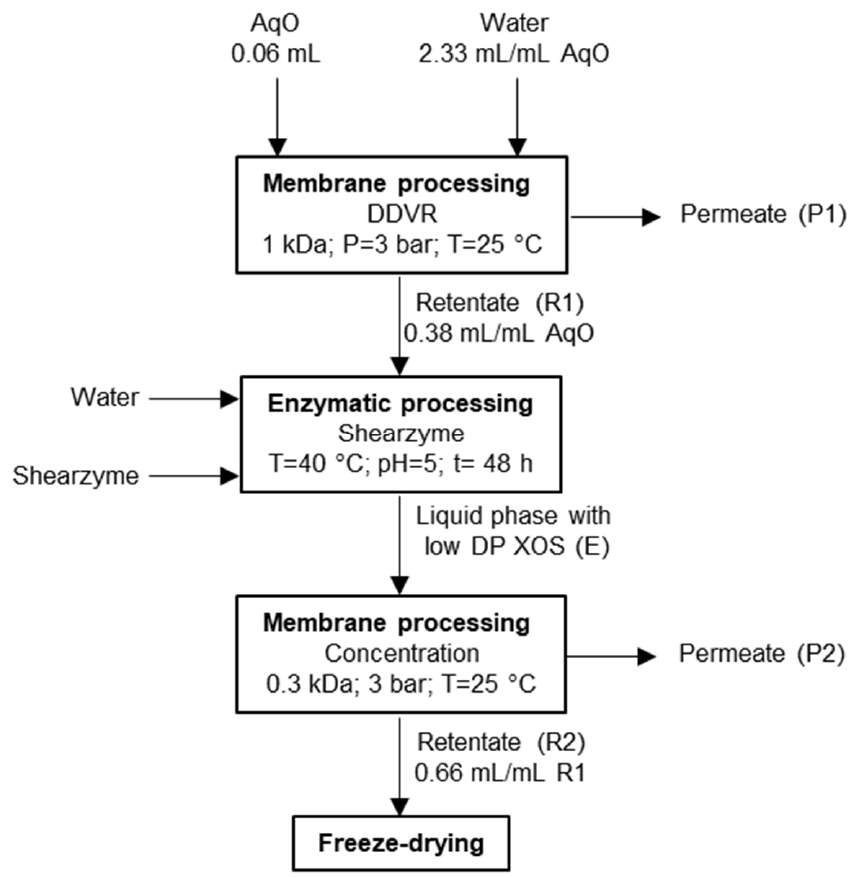
Figure 2. Scheme considered for refining the oligosaccharides present in the aqueous phase from fractionation (AqO).